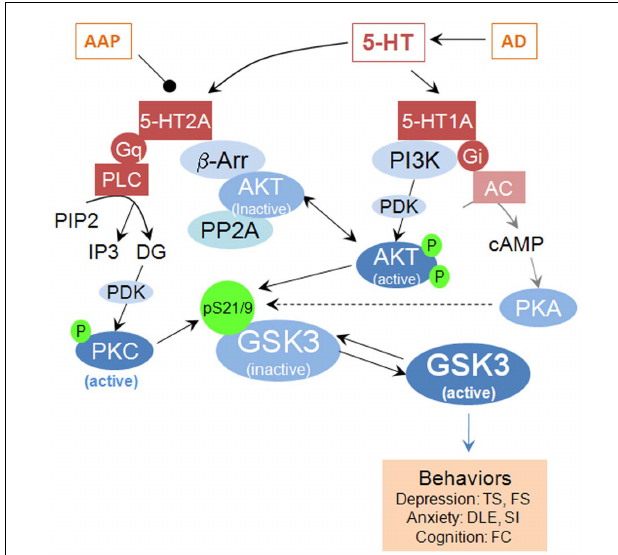
FIGURE 1 | Schematic illustration of GSK3 as an intermediate modulator of 5-HT receptor-mediated signaling pathways and physiological functions. AAP, atypical antipsychotic; α , β , γ , G-protein subunits; AC, adenylyl cyclase; AD, antidepressant; β -arr, β -arrestin; DG, diacylglycerol; Gi/Gq, G-protein; GSK3, glycogen synthase kinase-3; 5HT, serotonin; 5-HT1A and 5-HT2A, serotonin receptor subtypes; P, phosphorylated; PDK1, phosphoinositide-dependent kinase-1; PI3K, phosphatidylinositol-3-kinase; PP1/PP2A: protein phosphatase 2A; PKA, protein kinase A; PKC, protein kinase C.TS, tail suspension; FS, forced swim; DLE, dark-light emergence; SI, social interaction; FC, fear conditioning.